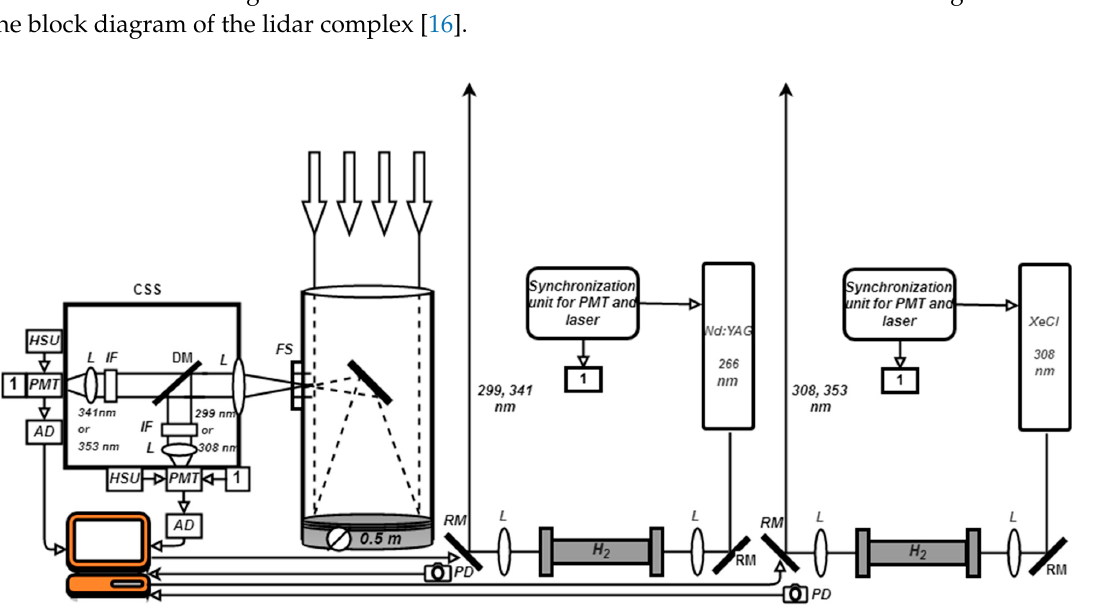
Figure 1. Block diagram of the ozone lidar complex: field stop (FS), cuvette of spectral selection with a photomultiplier (CSS), interference filter (IF), dichroic mirror (DM), amplifiers–discriminators (AD), high-voltage supply units (HSU), rotary mirrors (RM), lenses (L), photomultiplying tube (PMT), photodiod е (PD).